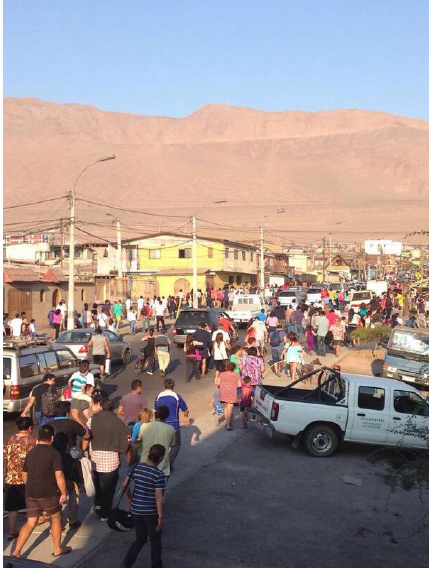
Figure 5. Preventive evacuation of 16 March 2014 (CNN Chile,